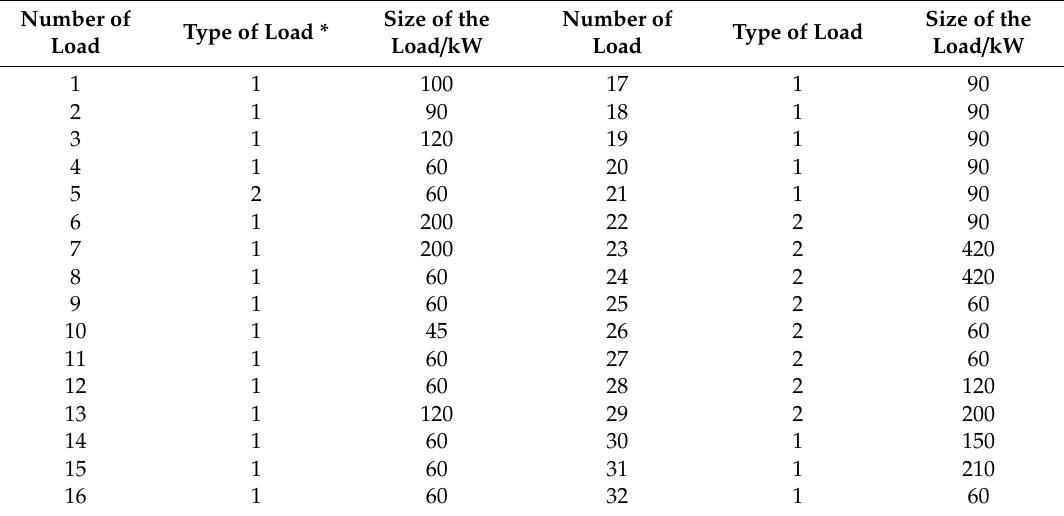
Table 1. Load parameters of the IEEE-33 bus standard